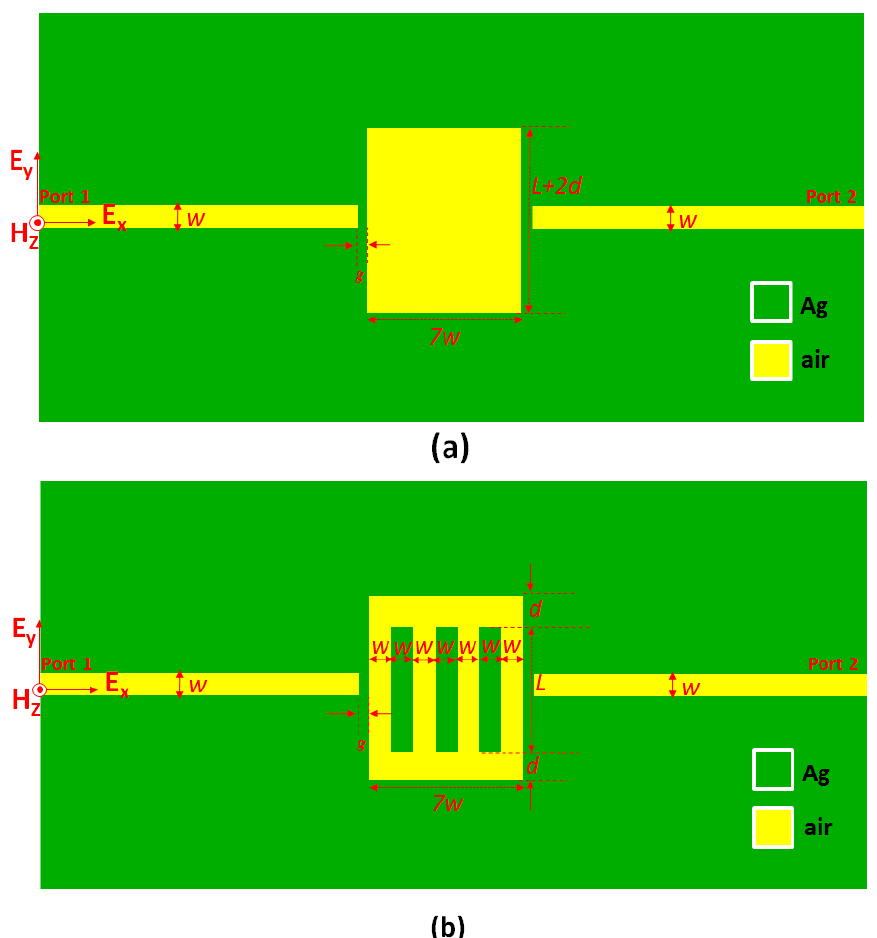
Figure 1. Schematic illustration of the proposed MIM waveguide containing the straight waveguides (width w), one centrally coupled rectangular cavity (width 7w and length L + 2 d ) ( a ) excluding and ( b ) including three Ag baffles in the rectangular cavity. The Ag buffers uniformly distribute in the rectangular cavity. The gap distance between the rectangular cavity and the straight waveguides is g .